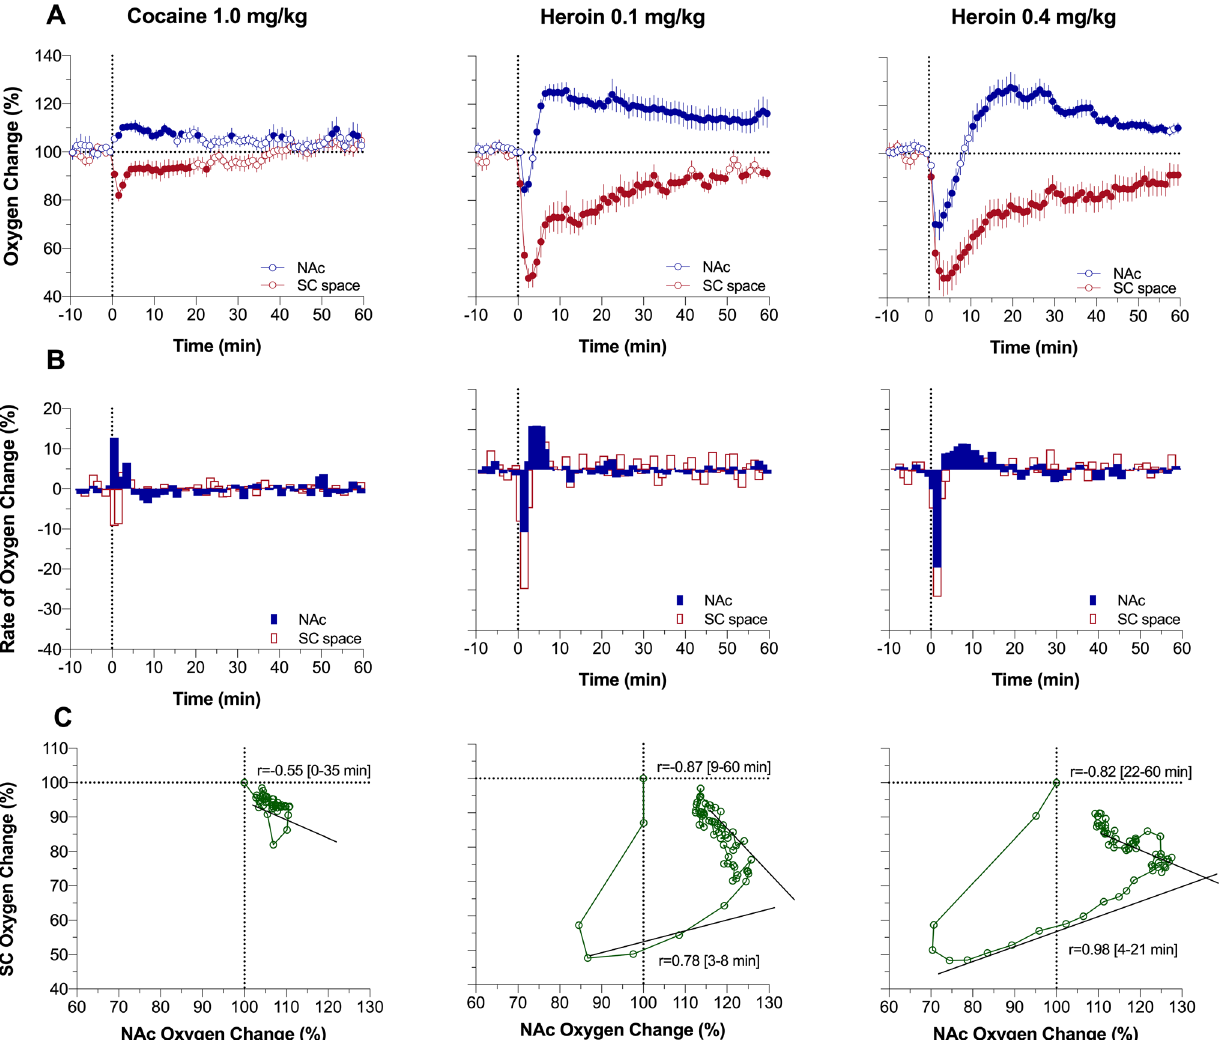
Figure 3. Relationships between changes in oxygen levels in the nucleus accumbens (NAc) and subcutaneous (SC) space induced by intravenous cocaine and heroin in awake, freely moving rats. Slow time-course analysis. ( A ) Mean (± SEM) changes in oxygen levels relative to baseline (100%) calculated with 1-min time bins. Vertical hatched lines show onset and offset of stimulus presentation. Filled symbols mark values significantly different from pre-stimulus baseline ( P < 0.05). ( B ) Rate of oxygen changes. ( C ) Correlative relationships between oxygen changes in two recording locations shown for time intervals of brain oxygen increases. Coefficients of correlation for heroin (r) are shown for two time intervals: brain oxygen increase from its lowest point to peak and subsequent return to baseline (timing of these intervals are shown in brackets). Asterisks show significance of coefficients of correlation (** and ***, P < 0.01 and 0.001, respectively). Data were obtained in 6 rats; the numbers of averaged responses are 11–14 (see Table in Supplementary materials for ANOVA values and n in each